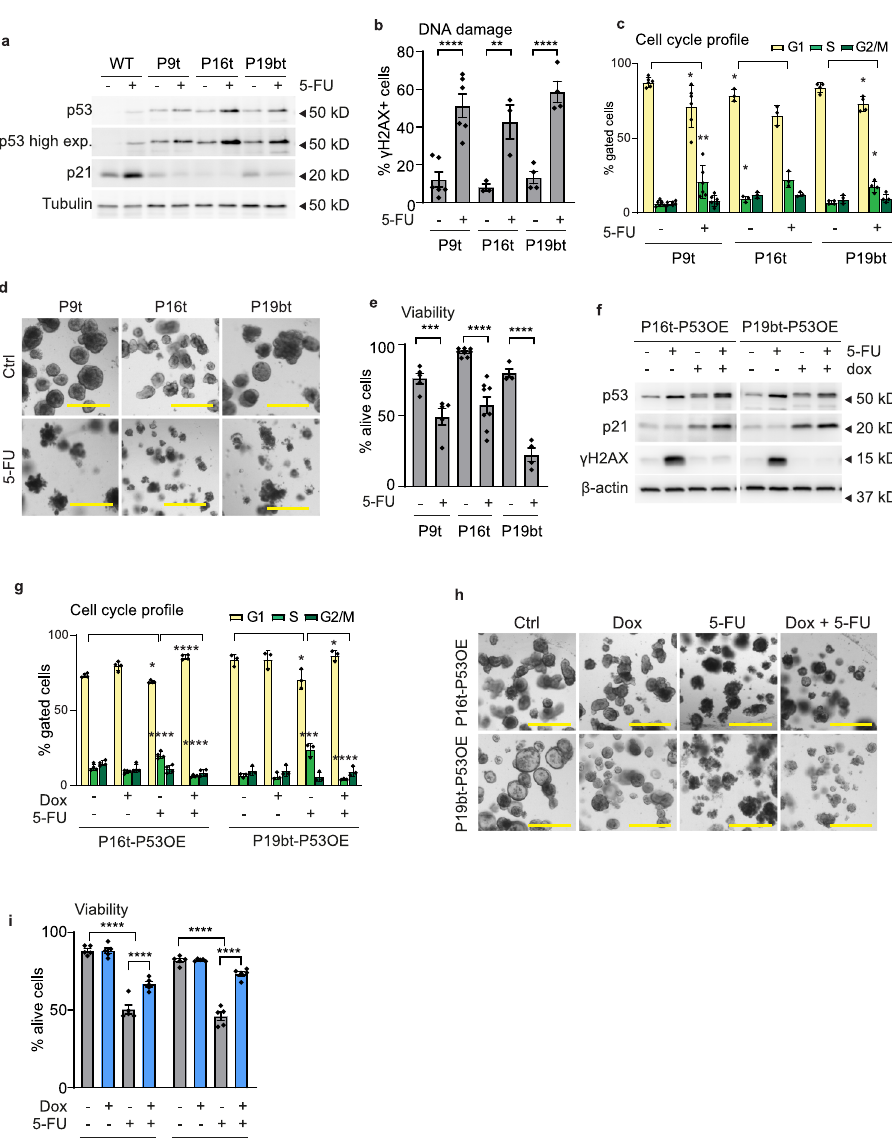
Fig. 4 Inactive p53 leads to 5-FU-induced DNA damage and cell death due to the lack of G1 arrest in PDOs. a Western blot detection of p53, p21 and tubulin in WT and P9t, P16t and P19bt organoids treated with 5-FU for 48 h (representative for n = 3). WT, P9t, P16t and P19bt were run together on the same gels. b Quanti fi cation of cells with DNA damage by fl ow cytometry of P9t, P16t and P19bt organoids treated with 5-FU for 48 h and stained with anti- γ H2AX (mean ± SEM, n = 6 (P9t), 3 (P16t), 4 (P19bt), one-way ANOVA, Sidak ’ s multiple comparisons test). c Cell cycle pro fi le analysis by fl ow cytometry of P9t, P16t, and P19bt organoids treated with 5-FU for 48 h and stained with DAPI (mean ± SEM, n = 6 (P9t), 3 (P16t), 4 (P19bt) 4, P9t and P16t: unpaired t -test, P19bt: Mann – Whitney test). d , e Bright fi eld images ( d ) and cell viablility analysis ( e ) of P9t, P16t, and P19bt organoids treated with 5-FU for 6 days (scale bar = 500 µ m, mean ± SEM, n = 5 (P9t), 8 (P16t), 4 (P19bt) 4, one-way ANOVA, Sidak ’ s multiple comparisons test). f , g Western blot detection of p53, p21, γ H2AX, and β -actin ( f ) and cell cycle pro fi le analysis ( g ) in doxycycline-inducible P16t-P53OE and P19bt-P53OE organoids treated with 5-FU for 48 h. Doxycycline treatment (200 ng/ml) was started 16 h before and washed away 24 h after 5-FU administration (representative for n = 3, mean ± SEM, n = 4 (P16t-P53OE), 3 (P19bt-P53OE), one-way ANOVA, Sidak ’ s multiple comparisons test). P16t-P53OE and P19bt-P53OE were run together on the same gels. h , i Bright fi eld images ( h ) and cell viability analysis ( i ) of doxycycline-inducible P16t-P53OE and P19bt-P53OE organoids treated with 5-FU for 6 days. Doxycycline treatment (200 ng/ml) was started 16 h before and washed away 24 h after 5-FU administration (scale bar = 500 µ m, mean ± SEM, n = 5, one-way ANOVA, Sidak ’ s multiple comparisons test). * p < 0.05, ** p < 0.01, *** p < 0.001, **** p <